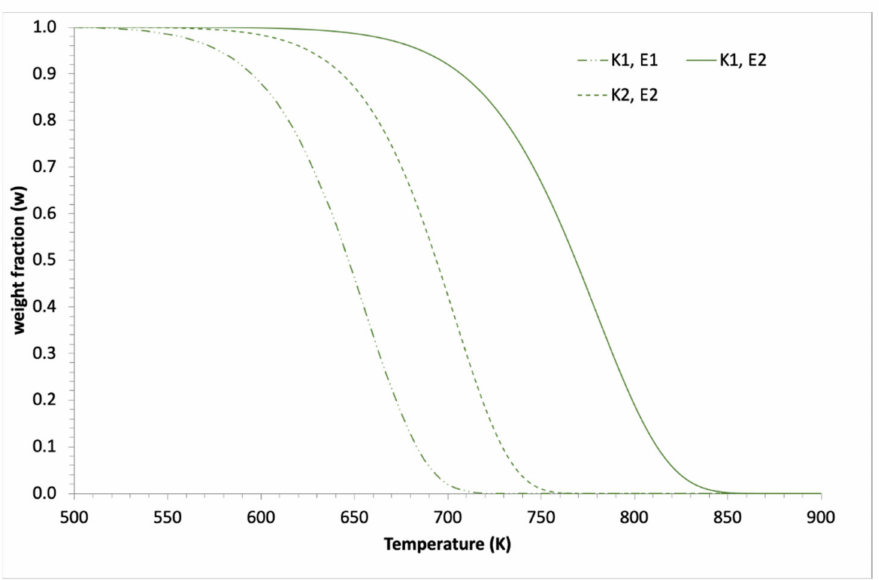
Figure 1. Effect of activation energy and the preexponential factor on the position and shape of the decomposition curve at a fixed heating rate of 10 K/min. Values used in the simulation: k 1 = 10 6 s − 1 , k 2 = 10 7 s − 1 , E 1 / R = 12,500 K, E 2 / R = 15,000 K.